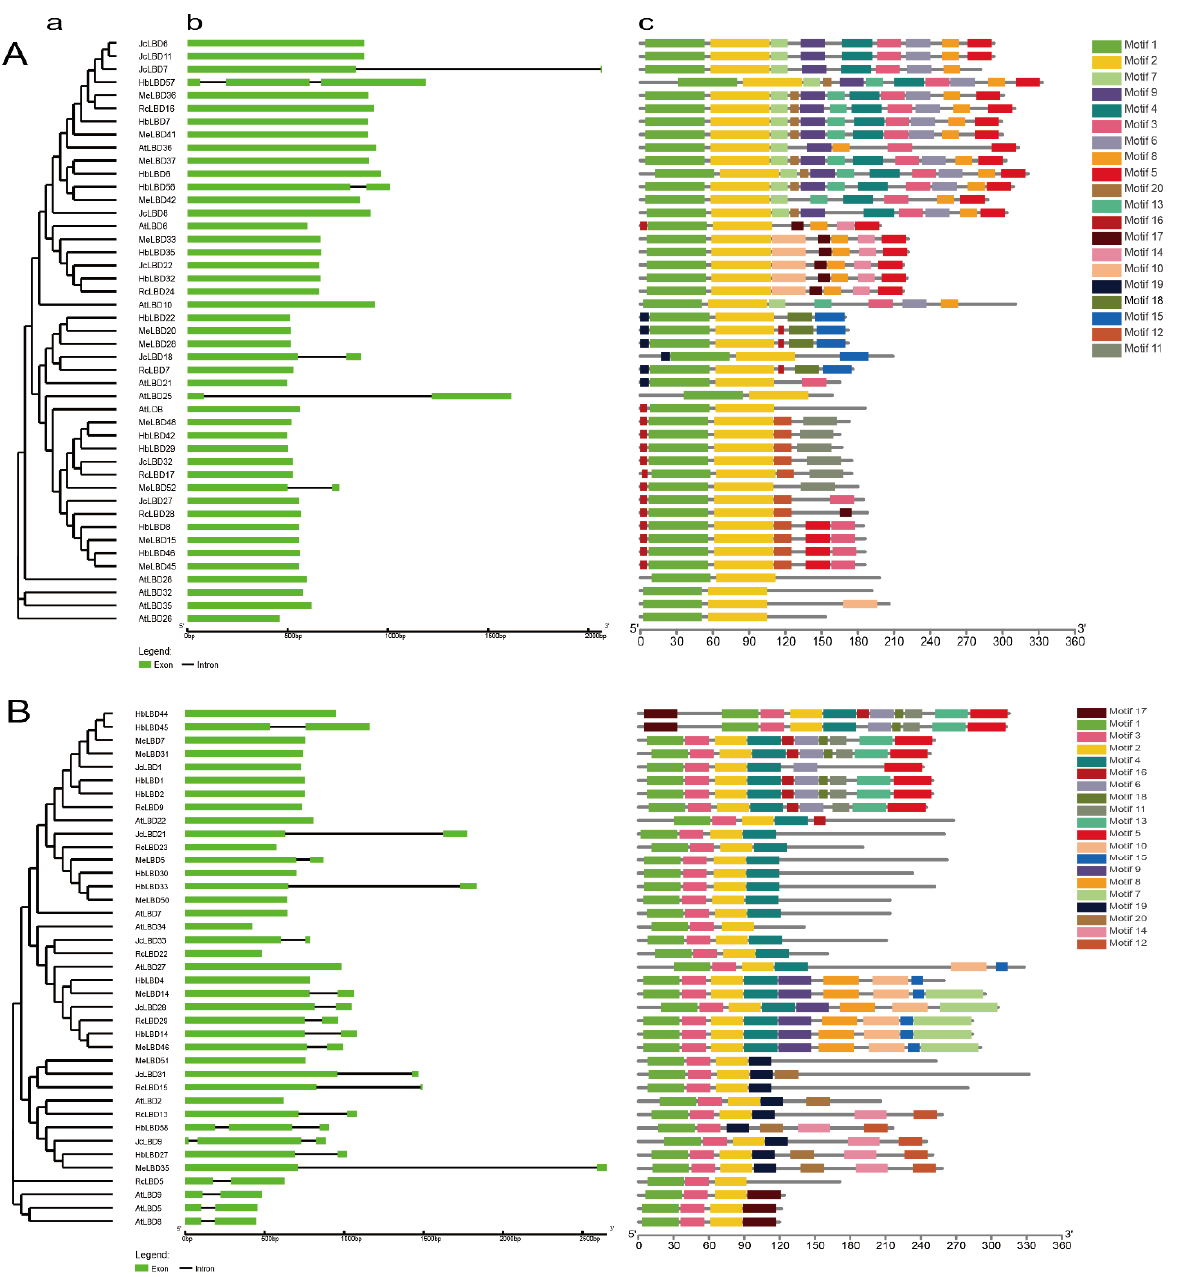
Figure 2. The phylogenetic relationship, gene structure, and conserved protein motifs of Euphorbiaceae LBD genes. ( A , B ) are phylogenetic tree, gene structure and conserved motif of Class Ia and Ie of Euphorbiaceae, respectively. (a) A maximum likelihood tree was constructed by MEGE 10 with 1000 bootstrap replicates; (b) Exon-introns structure of LBD s performed by GSDS2; (c) The conserved motifs of Euphorbiaceae species LBD proteins analysed by MEME suit.